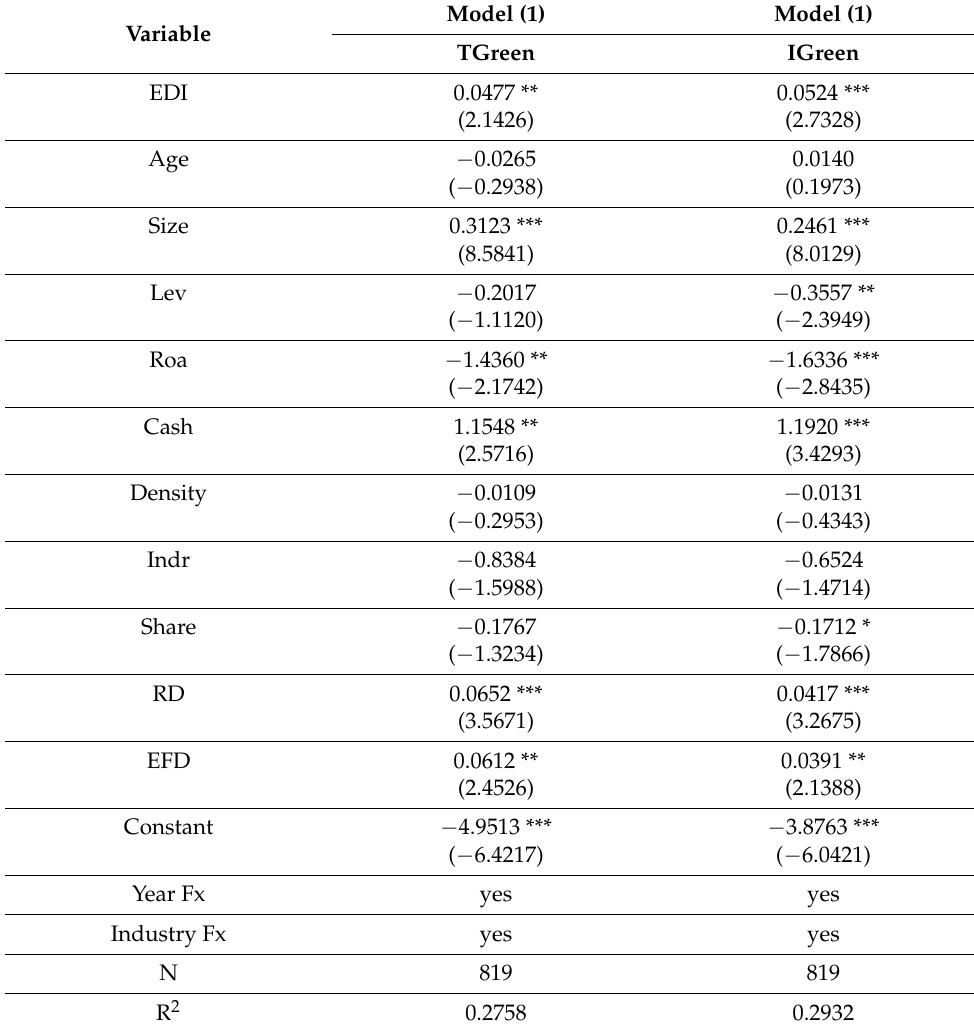
Table 4. Results of the regression analysis between buyers’ environmental information disclosures and corporate green technological